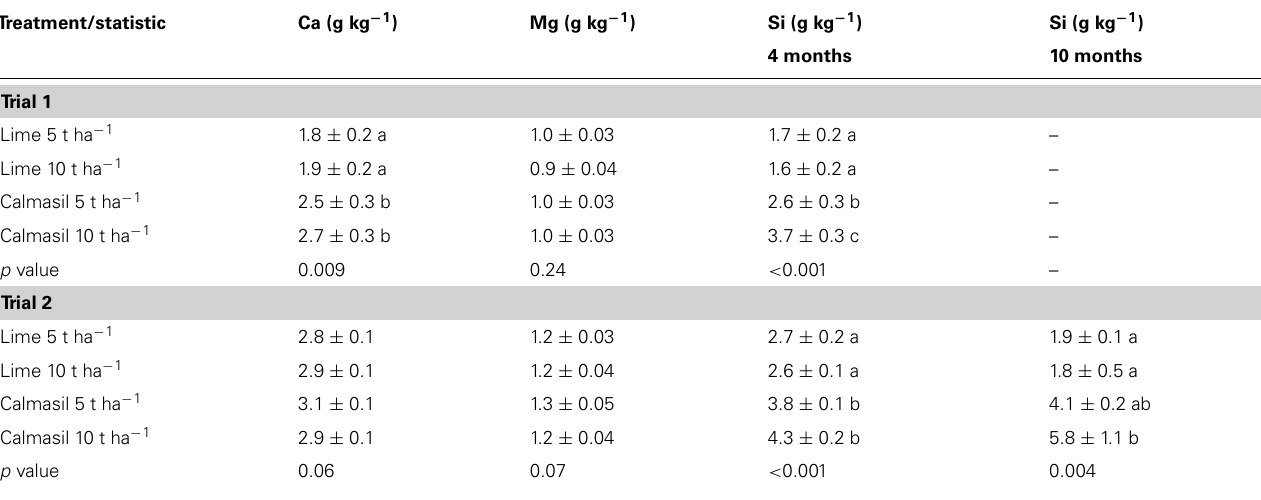
Treatment/statistic